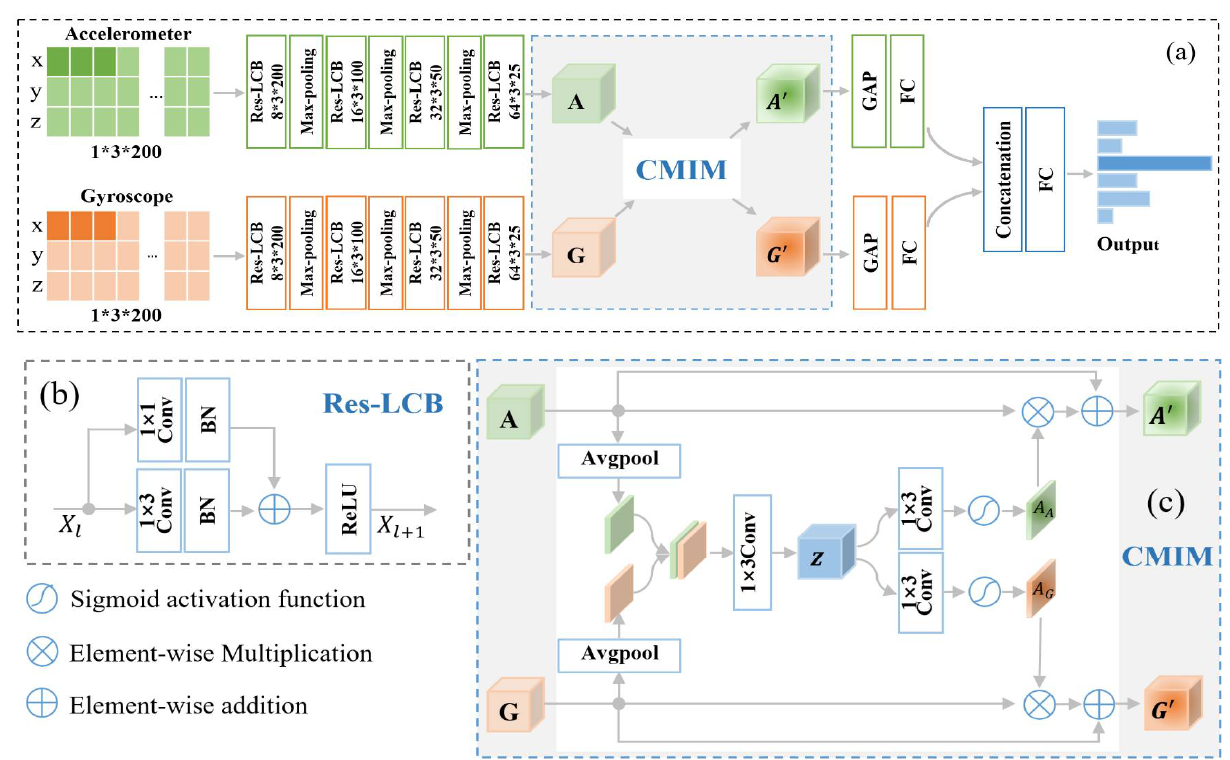
Figure 2. The architecture of our proposed cross-modality interaction network (CMI-Net). ( a ) Our proposed CMI-Net. The size of the feature maps is marked after every residual-like convolution block (Res-LCB) layer. Here, “A” and “G” denote the modality-specific features for the accelerometer and gyroscope, respectively, and “ (cid:1827) (cid:4593) ” and “ (cid:1833) (cid:4593) ” denote the refined features after modality interaction. “GAP” and “FC” are the global average-pooling layer and fully connected layer, respectively. ( b ) Res-LCB and ( c ) cross-modality interaction module (CMIM).